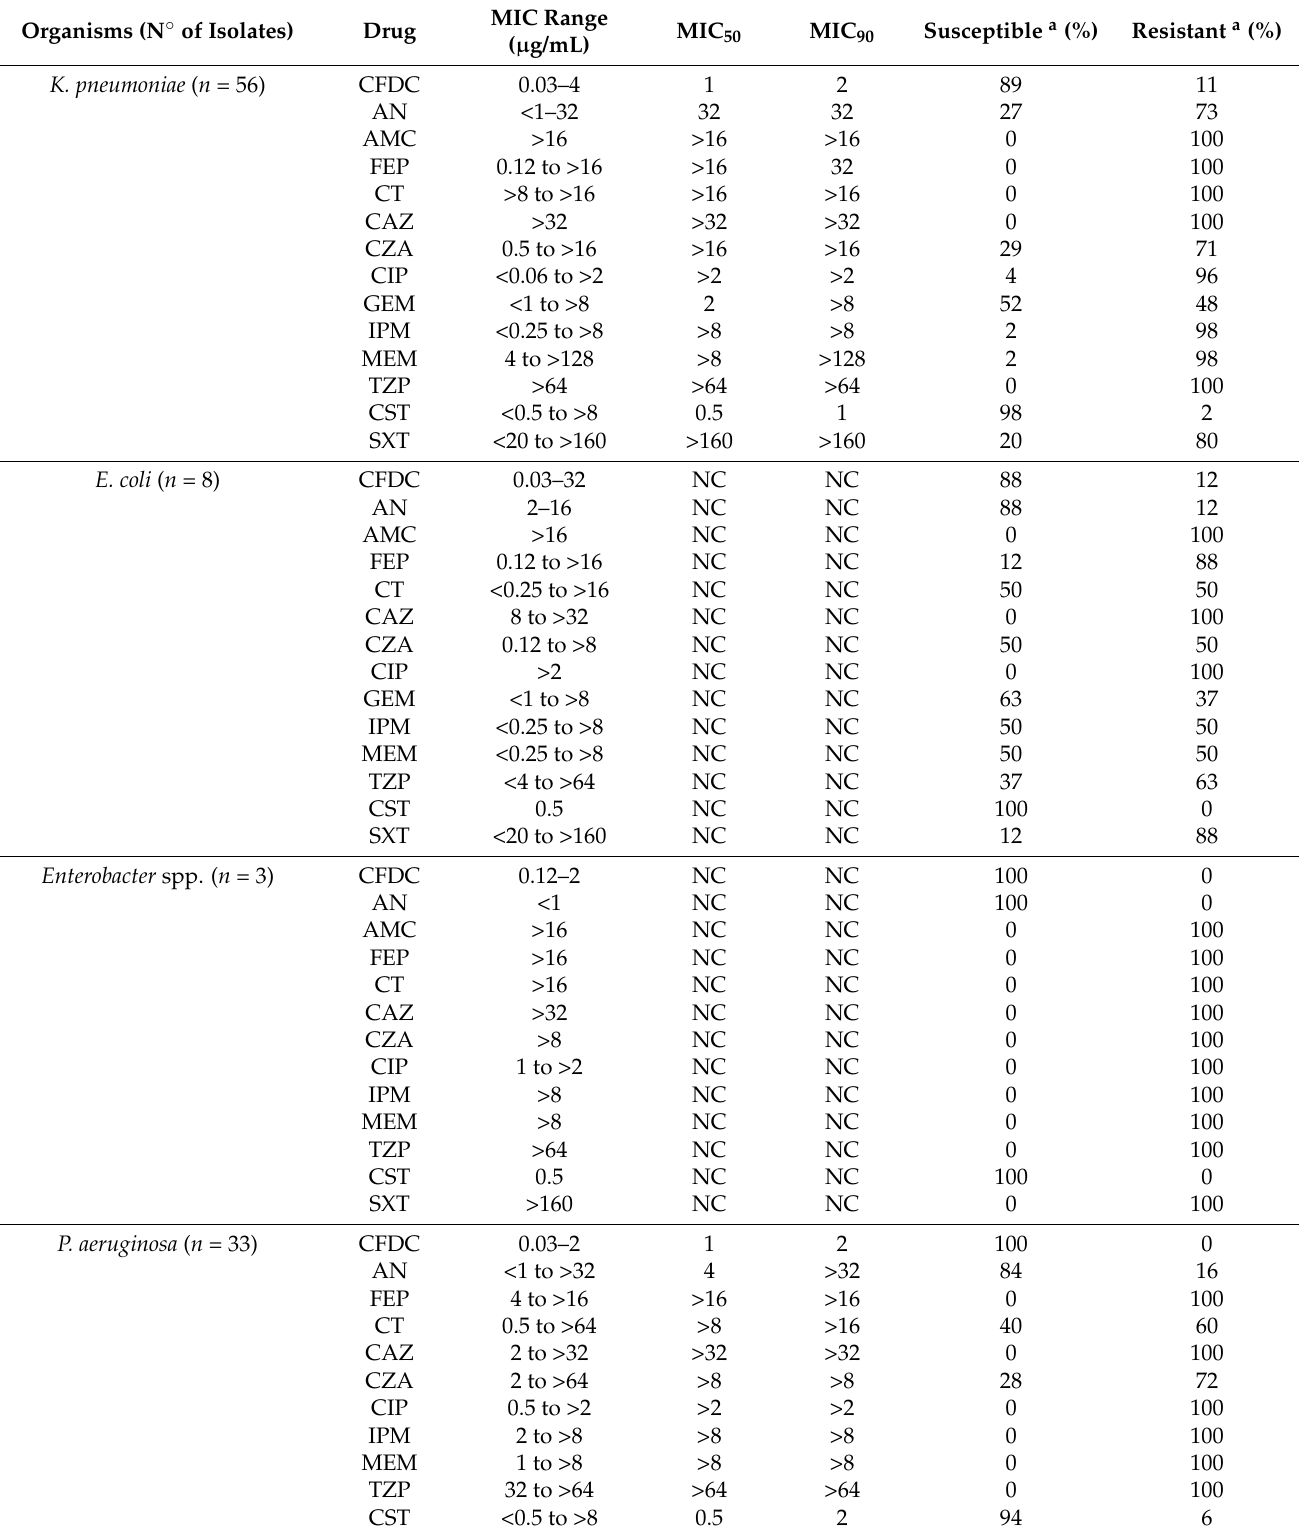
Table 1. In vitro activity of antibiotics against Gram-negative bacteria collected during the study